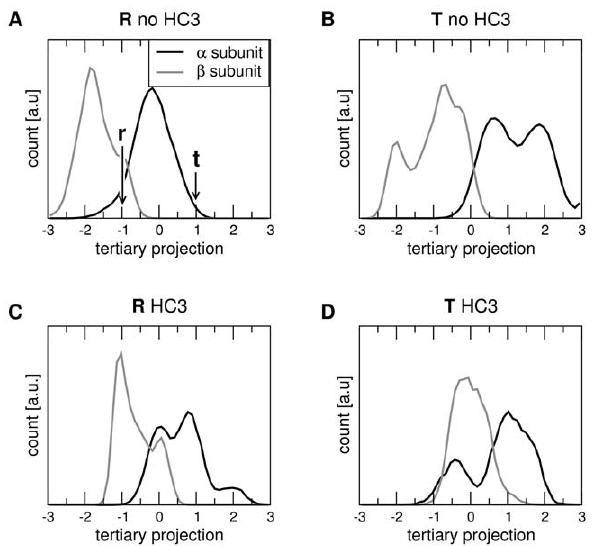
Figure 7. Populations of tertiary states of the a (black) and b (grey) subunits as a function of quaternary state (T/R) and the HC3 protonation. The tertiary states were computed from the projections of the subunit structures during simulation onto the tertiary difference vectors connecting the T and R tertiary X-ray structures, denoted by t and r . The projections were normalized such that the r and t tertiary structure correspond to a projection of 2 1 and + 1, respectively. A simulation frame was assigned to the R or to the T quaternary structure, if the projection onto the vector connecting the R and T quaternary states was ,2 0.5 or . + 0.5, respectively (compare Fig. 5). Populations in Hb simulations without deprotonated His( b )146 are denoted by ‘ T / R no HC3’ (A/B), and simulations with protonated His( b )146 are denoted by ‘ T / R HC3’ (C/D).